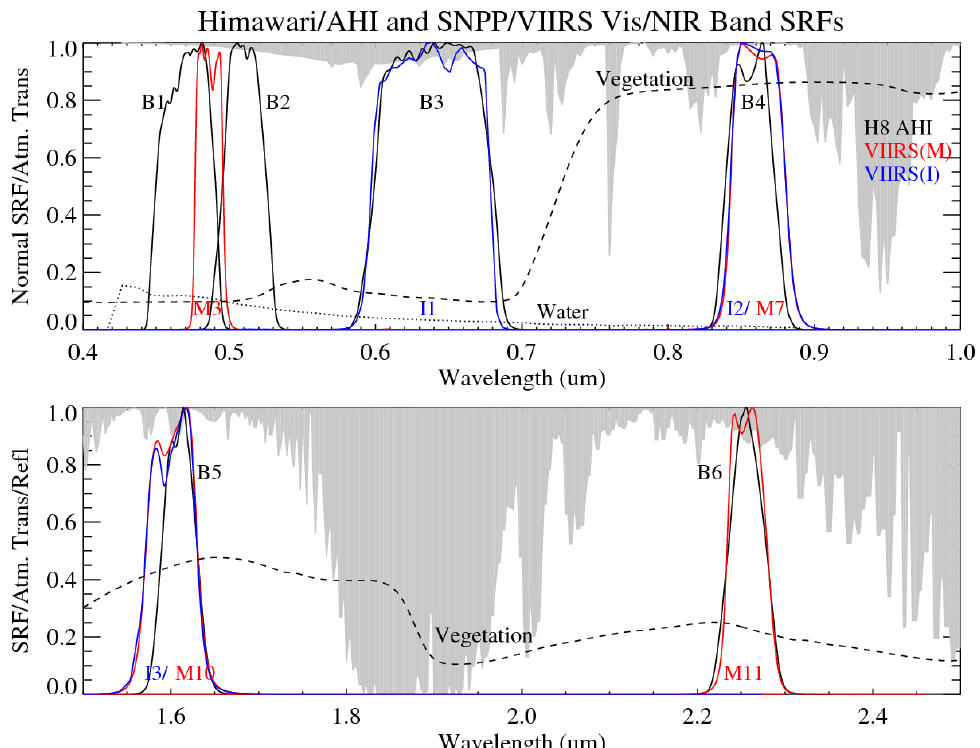
Figure 1. Spectral response function (SRF) of AHI (black) and VIIRS (red for M bands and in blue for I bands), as well as the atmospheric transmission (gray shadow), and vegetation and water spectra (dark, dashed lines). The VIIRS SRFs plotted are of Non-Government (NG) version [6].